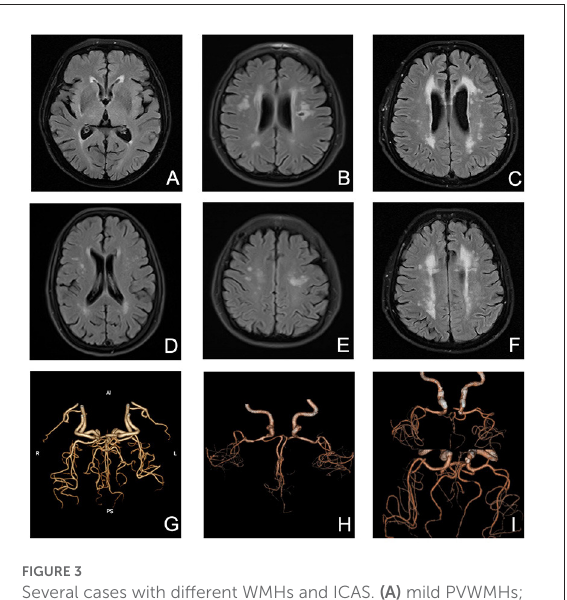
FIGURE2 The proportional frequency of modified Rotterdam Progression scale (mRPS) scores and its distribution with ICAS severity are depicted.